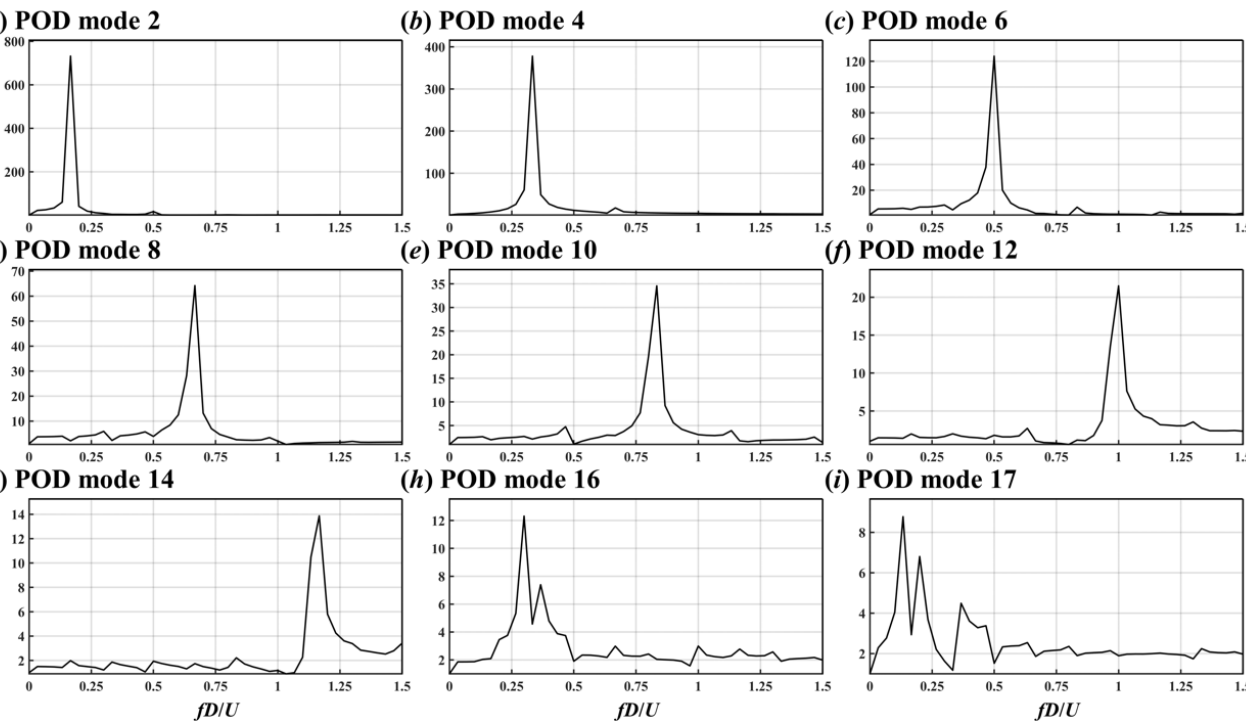
Figure 17. PSDs of the 2nd ( a ), 4th ( b ), 6th ( c ), 8th ( d ), 10th ( e ), 12th ( f ), 14th ( g ), 16th ( h ), and 17th ( i ) POD modes for the flow around the single cylinder. It is clear from Figure 17 that the 2nd, 4th, 6th, 8th, 10th, 12th, and 14th POD modes had a relatively prominent spectral peak, corresponding to St = 0.16, 0.32, 0.48, 0.64, 0.8,